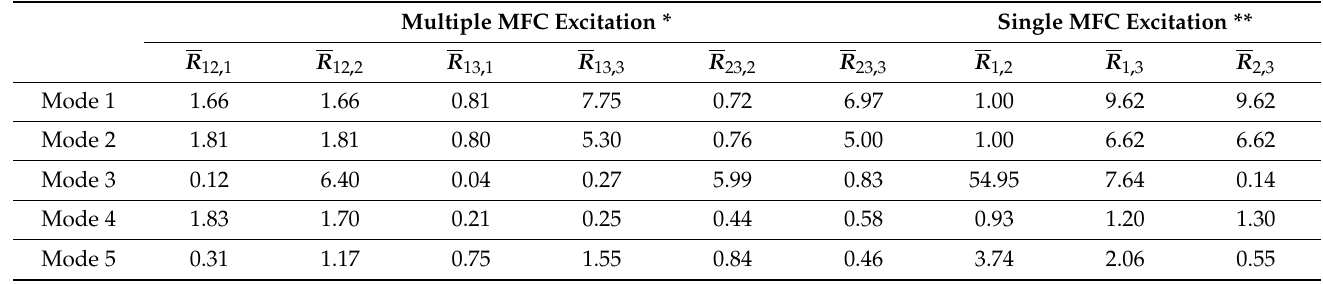
Table 3. The response amplitude of Node 127 under MFC superimposed and individual excitation. Multiple MFC Excitation